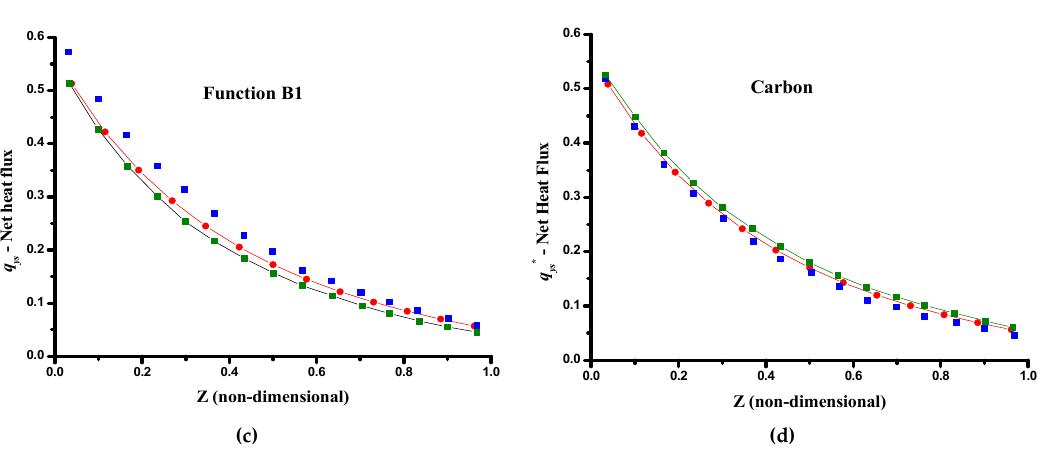
Figure 2. Dimensionless radiation heat flux density in y -direction at the middle of south wall (X = 0.5, Y = 0.0).